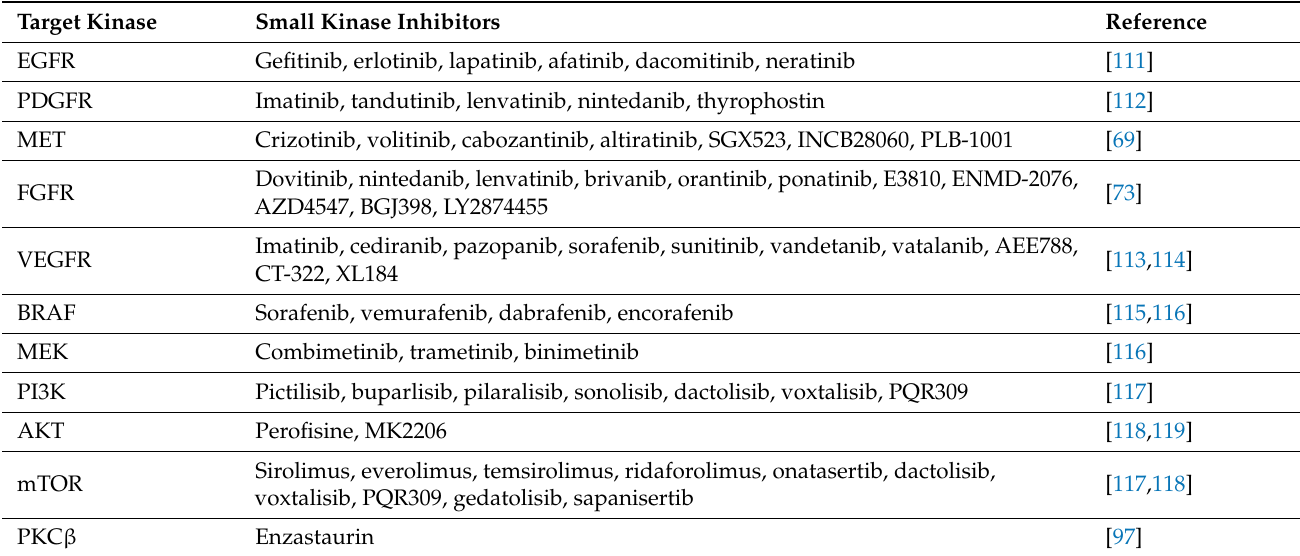
Table 1. Summary of the kinases and their small inhibitors evaluated in clinical trials for GBM. Target Kinase